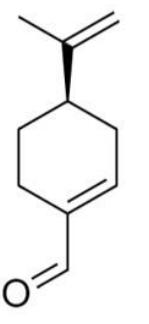
Figure 1. Figure 1. R-perillaldehyde.